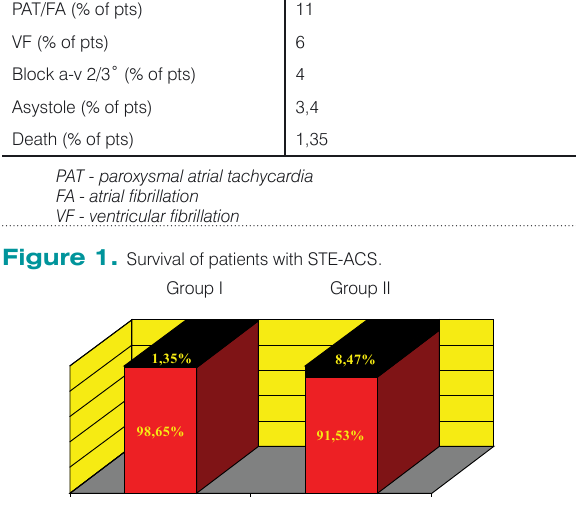
Table 5. Risk factors for death – univariate analysis.